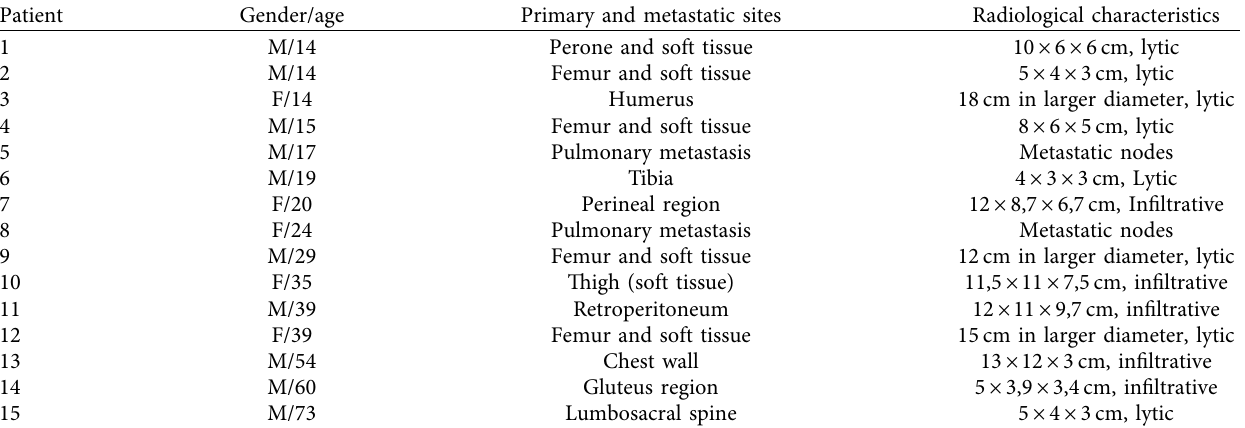
Table 1: Clinical and radiological